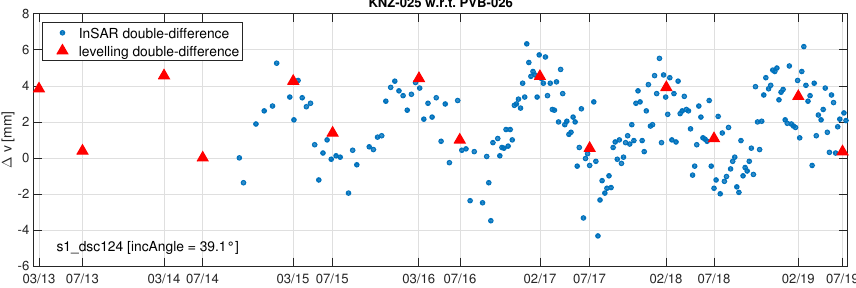
Figure 18. Comparison of InSAR and leveling double-differenced displacement time series projected to vertical over dam’s inundation weir.